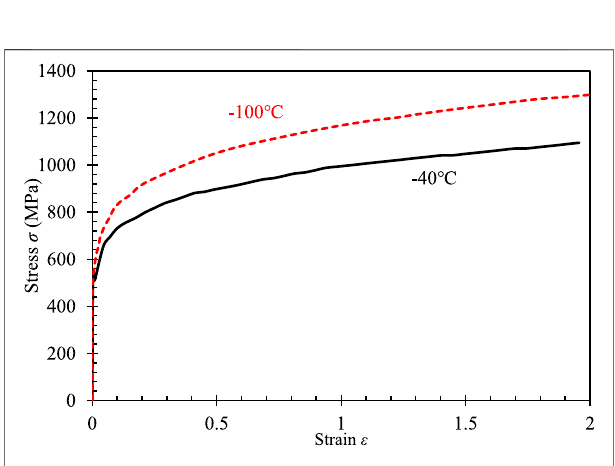
FIGURE 3 | True stress – strain curves at − 100 ° C and − 40 °